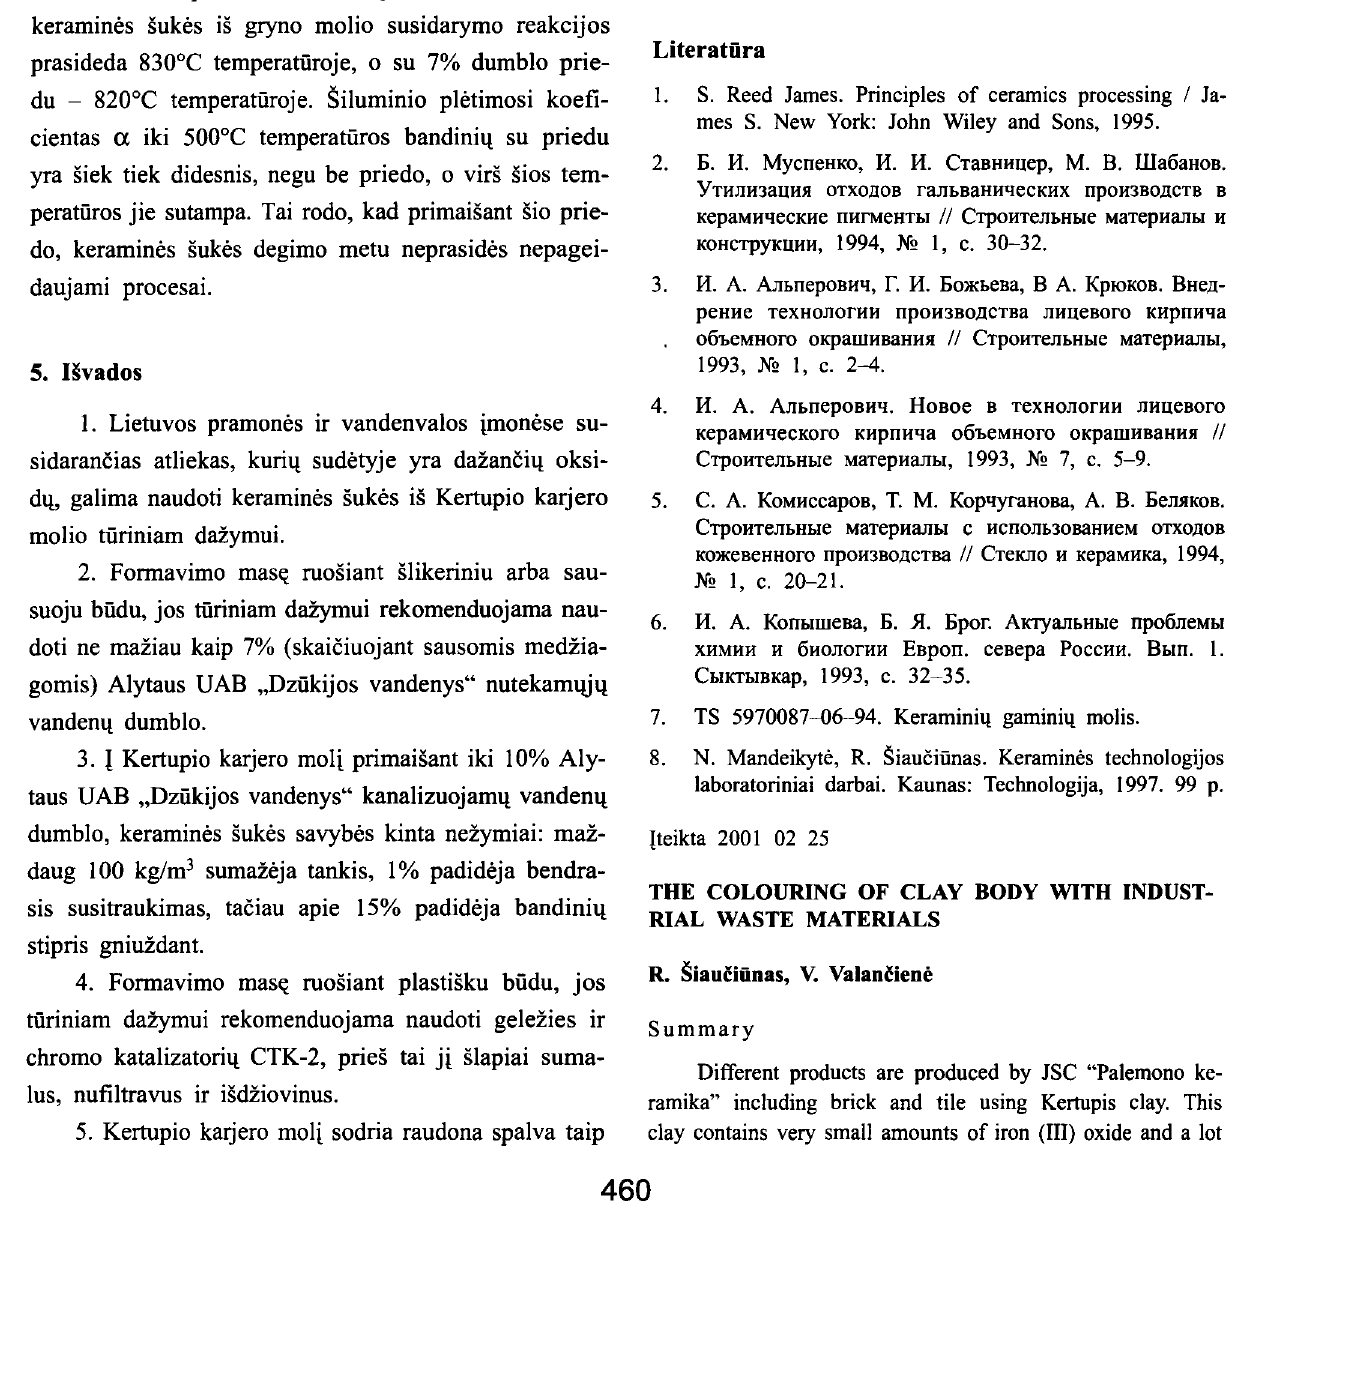
Table 9. Heat expansion and the coefficient of heat expansion of the natural Kertupis clay and the clay with 7% waste water sludge of JSC "Dziikijos vandenys" Molis Temperatiill! intervalas 20-100 20-200 0,028 Kertupio ~l,mm